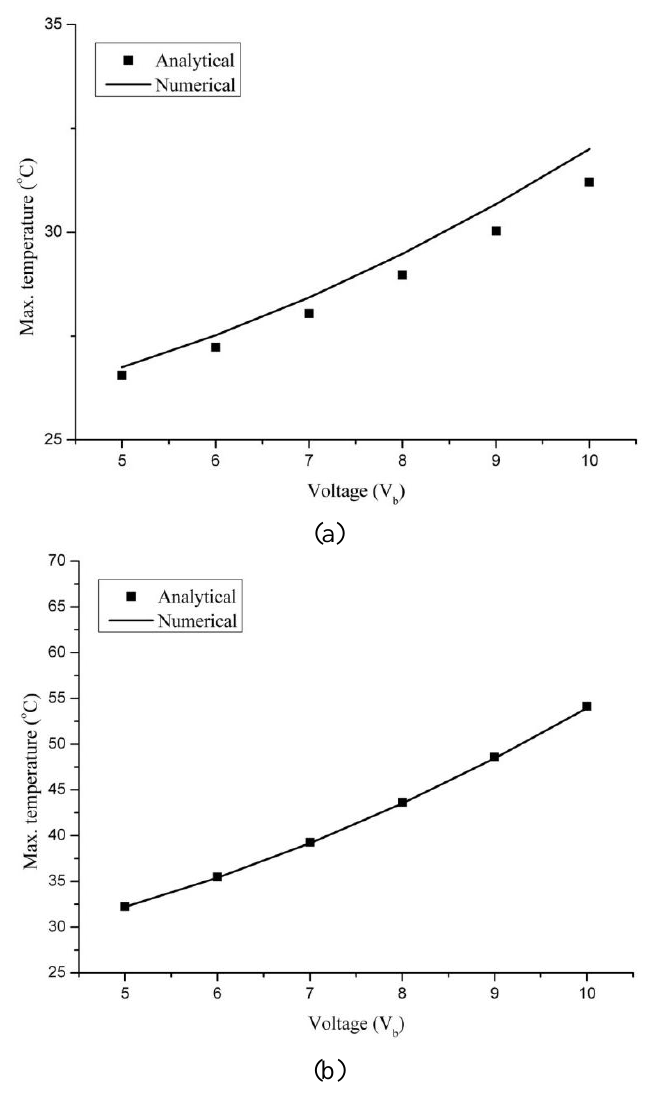
Figure 3. Comparison between analytical and simulation results for silicon (a) and